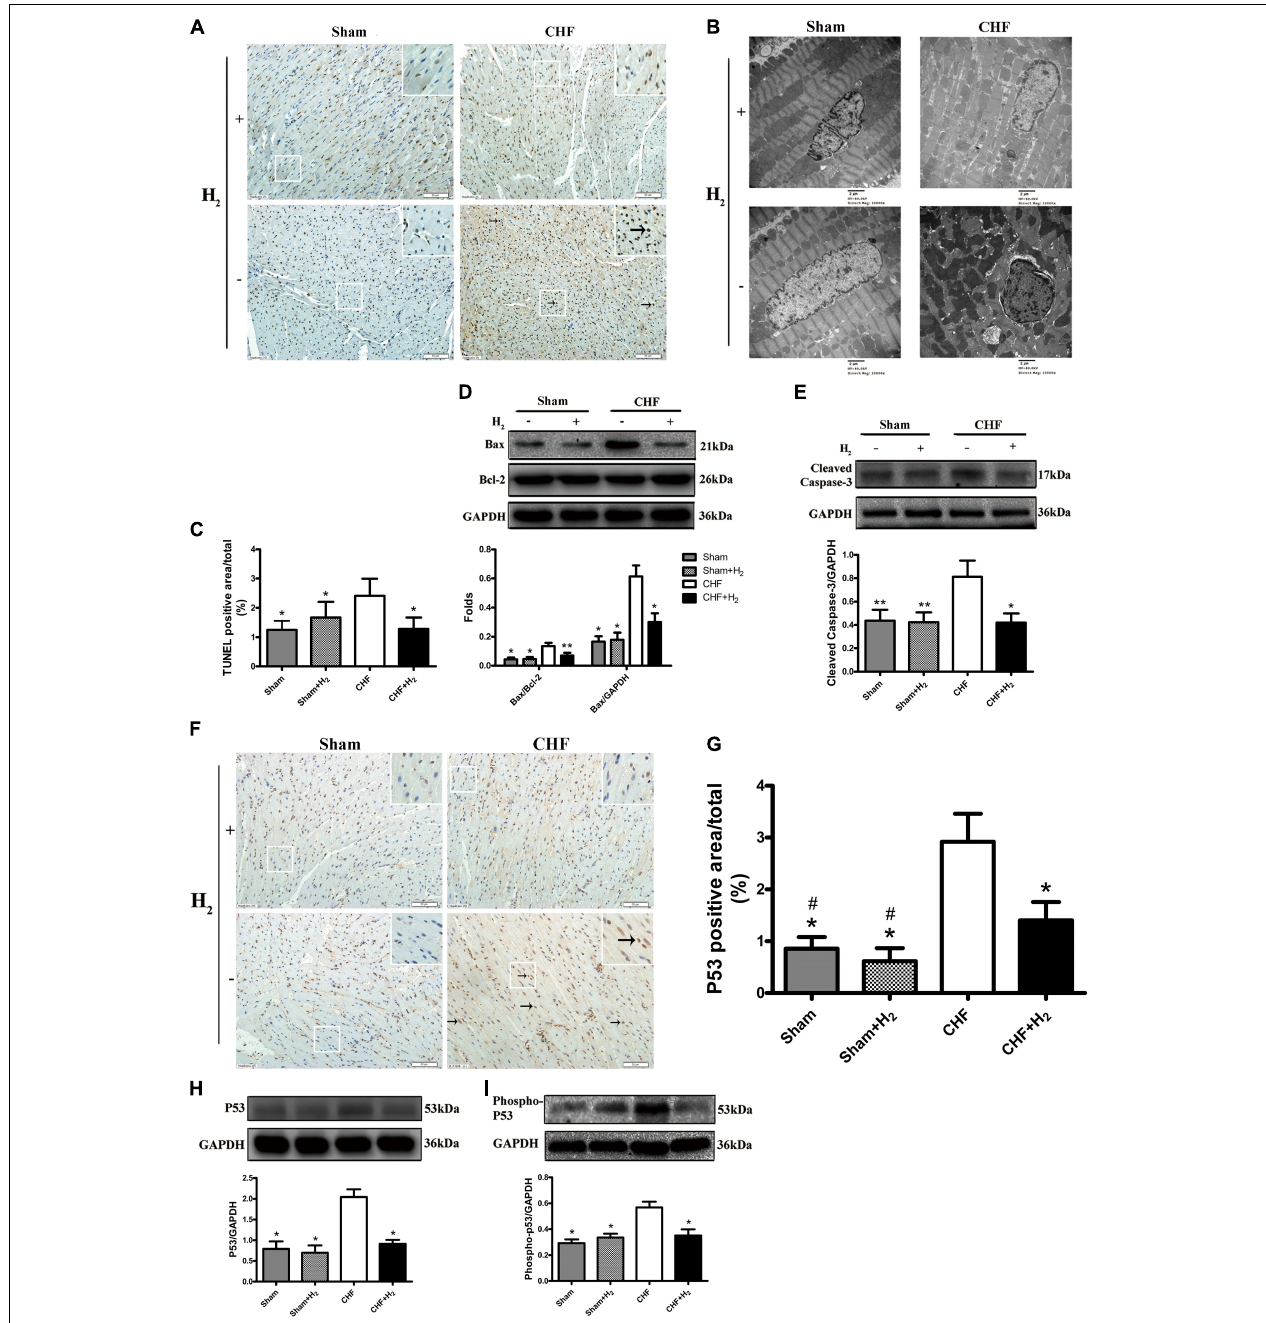
FIGURE 5 | Effects of H 2 on apoptosis and cardiac p53 protein expression in CHF. (A) Apoptosis was detected by TUNEL assay (brown nuclei, arrows). Representative photomicrographs are shown (magnification of 200 × ). Scale bar = 50 µ m. Inset: Magnified region illustrating non-apoptotic cardiomyocytes (blue nucleus) and apoptotic ones (brown nucleus). (B) Nuclei of cardiomyocyte was evaluated by observation under electronic microscopy (magnification of 10,000 × ). Scale bar = 2 µ m. (C) TUNEL staining was quantified as the percentage of apoptotic cardiomyocytes of the whole section area ( n = 8–9). (D,E) Confirmation by Western blot analyses for the expressions of cardiac Bax and cleaved-caspase-3. The ratios of Bax and bcl-2 are shown ( n = 8–10). (F) Representative photomicrographs of immunohistochemistry about p53 (brown nuclei, arrows) are shown (magnification of 200 × ). Scale bar = 50 µ m. Inset: Magnified region illustrating p53 negative cardiomyocytes (blue nucleus) and positive ones (brown nucleus). (G) P53 was determined by measuring the positive area and was expressed as a percentage of the whole section area ( n = 8–9). (H,I) Confirmation by Western blot analyses for the expression of cardiac p53 and phospho-p53. The ratios of phospho-p53 and p53 are shown ( n = 10). Representative photographs are shown. GAPDH was used as a loading control. Expressions of cleaved-caspase-3, Bax, p53 and phospho-p53 were, respectively, quantified as folds of GAPDH. The columns indicate the mean, and the bars indicate the SD (TUNEL and p53 staining) or SE (Western blotting). ∗ p < 0.01 vs. CHF; ∗∗ p < 0.05 vs. CHF; # p < 0.01 vs. CHF+H 2